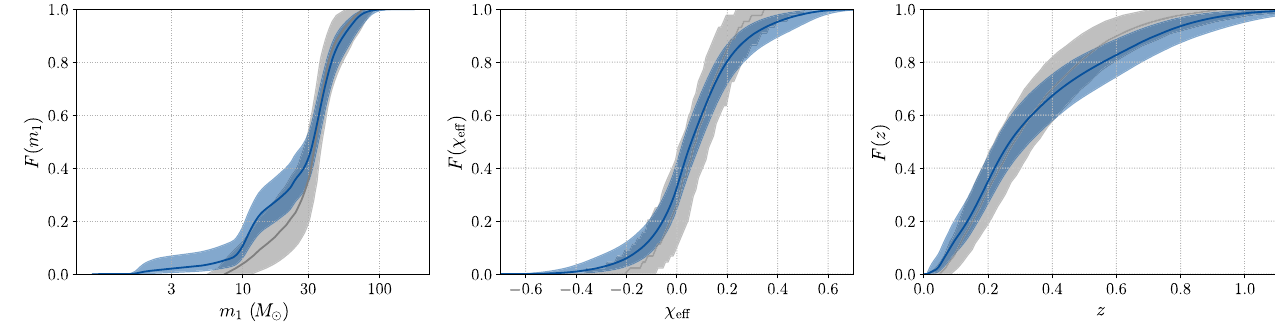
P ˆ F P x Þ =N of observed binary parameter distributions [derived from the FIG. 9. The empirical cumulative density function ¼ k ð k x Þ for each parameter x ] are shown in blue for primary mass (left), effective inspiral spin single-event cumulative distributions P k ð (center), and redshift (right). All binaries used in this study with FAR < 0 . 25 yr − 1 are included, and each is analyzed using our fiducial noninformative prior. For comparison, the gray bands show the expected observed distributions based on our previous analysis of GWTC-2 BBH [20]. Solid lines show the medians, while the shading indicates a 90% credible interval on the empirical cumulative estimate and selection-weighted reconstructed population, respectively. GW190814 is excluded from this analysis.